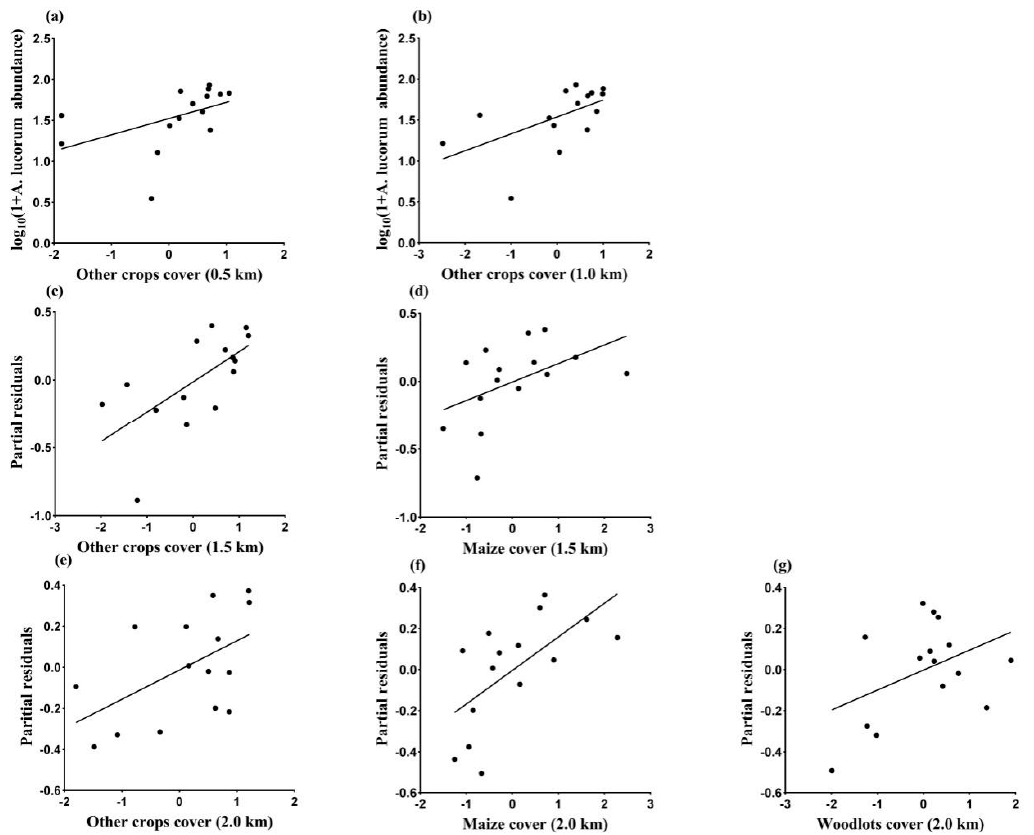
Figure 3. Relationships between the abundance of Apolygus lucorum in August and landscape variables with the best fitting model at each scale (0.5 km: ( a ); 1.0 km: ( b ); 1.5 km: ( c , d ); 2.0 km: ( e – g )), based on AICc analysis. The proportion of different landscape types cover was logit transformed and standardized.